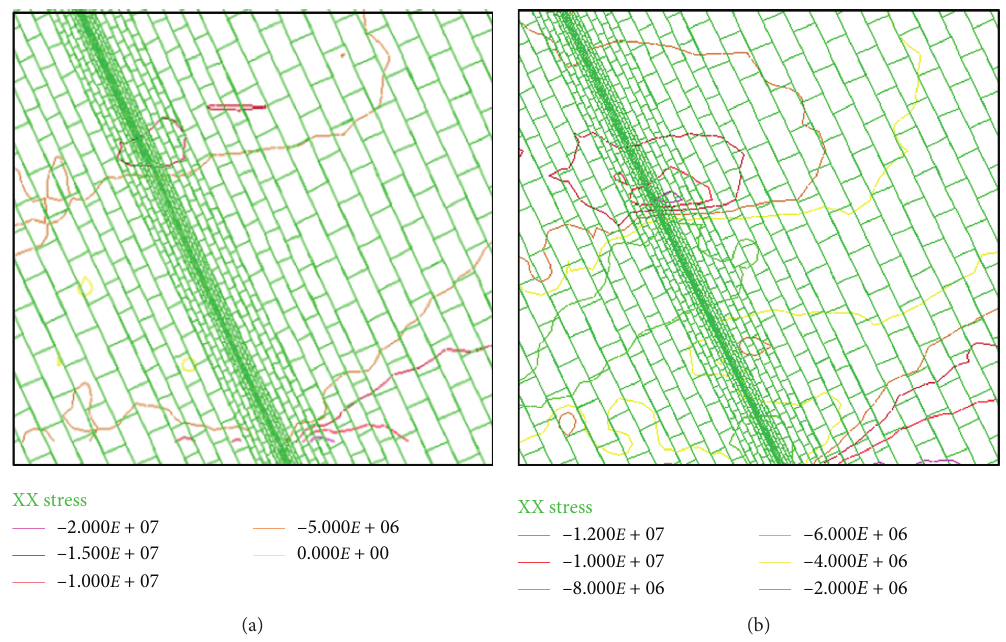
Figure 14: Surrounding rock horizontal stress distribution with 200m stope height. (a) Caving. (b)